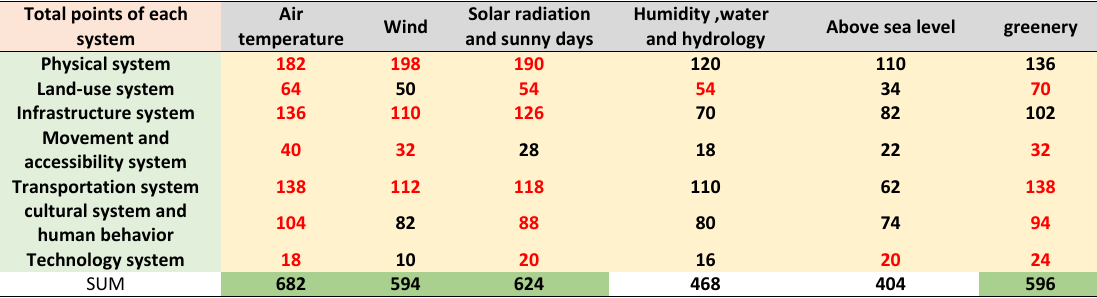
Table 11: A general view of the relationship between UESs and climate indicators